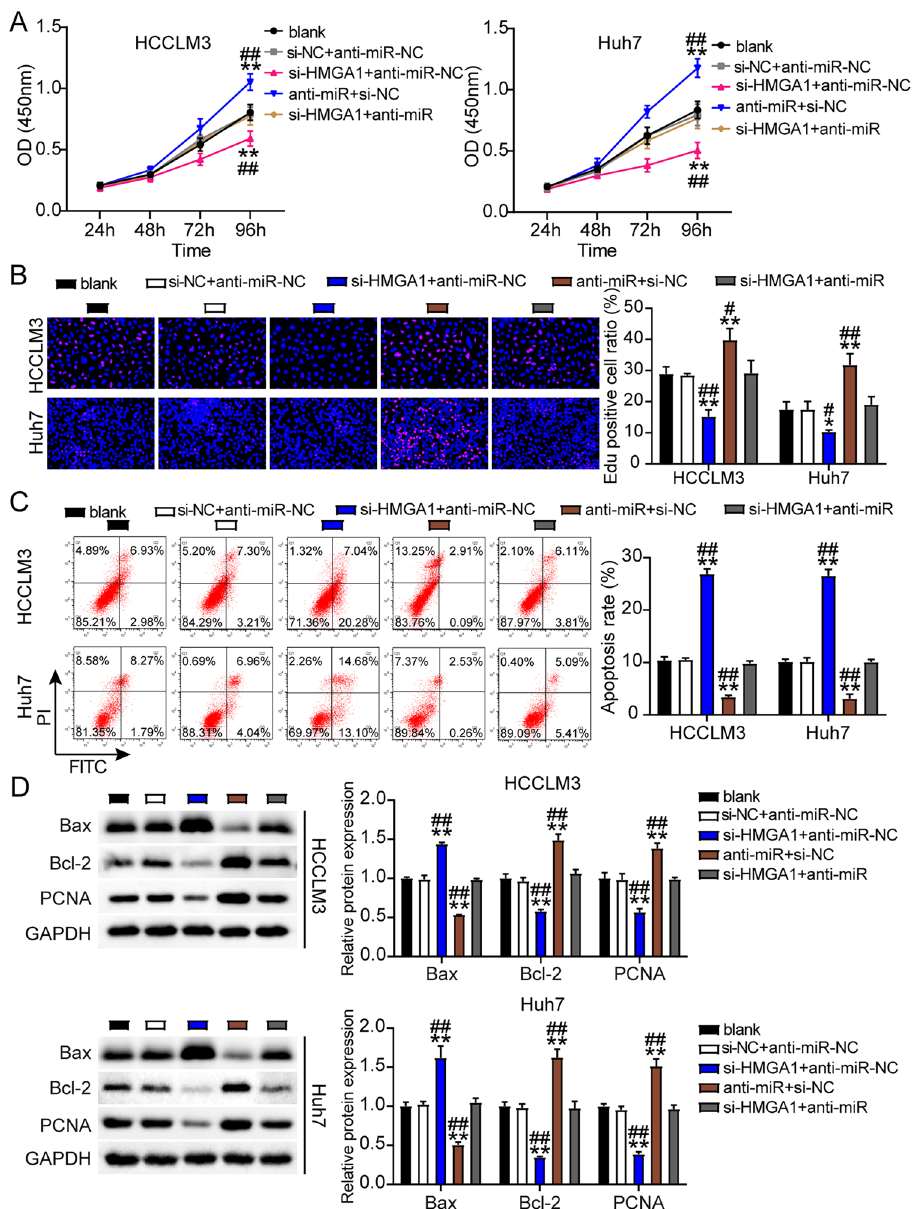
Figure 9. MiR-142-3p attenuated cell proliferation and elevated cell apoptosis by repressing HMGA1. ( A ) Cell viability determination using CCK8 assay. ( B ) Cell proliferation was determined by EdU assay. ( C ) Cell apoptosis was determined by FITC apoptosis detection kit. ( D ) Bax, Bcl-2 and PCNA protein expression were determined in HCCLM3 and Huh7 cells. # P < 0.05, ## P < 0.001 compared with si-HMGA1 + anti-miR; *P < 0.05, **P < 0.001 compared with blank. anti-miR: miR-142-3p inhibitor; Si-HMGA1 + anti-miR: SiRNA- HMGA1 + miR-142-3p inhibitor. NC: negative control; Si-HMGA1: